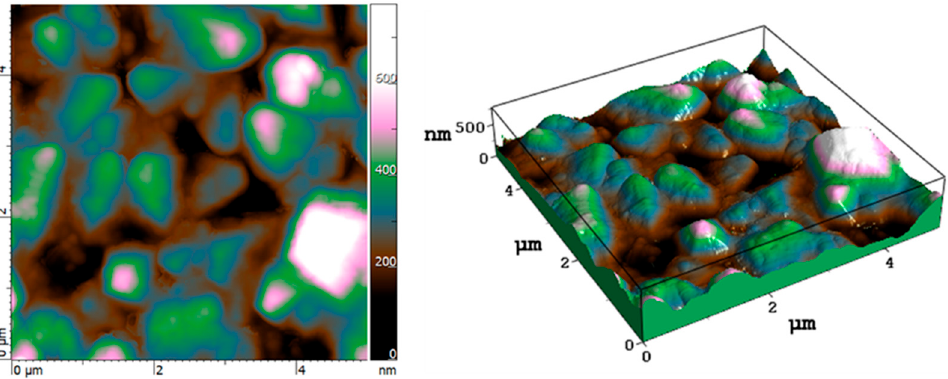
Figure 8. Top-view and tilted-view topographic AFM images (5 × 5 µ m 2 ) of the untreated BDD sample surface.